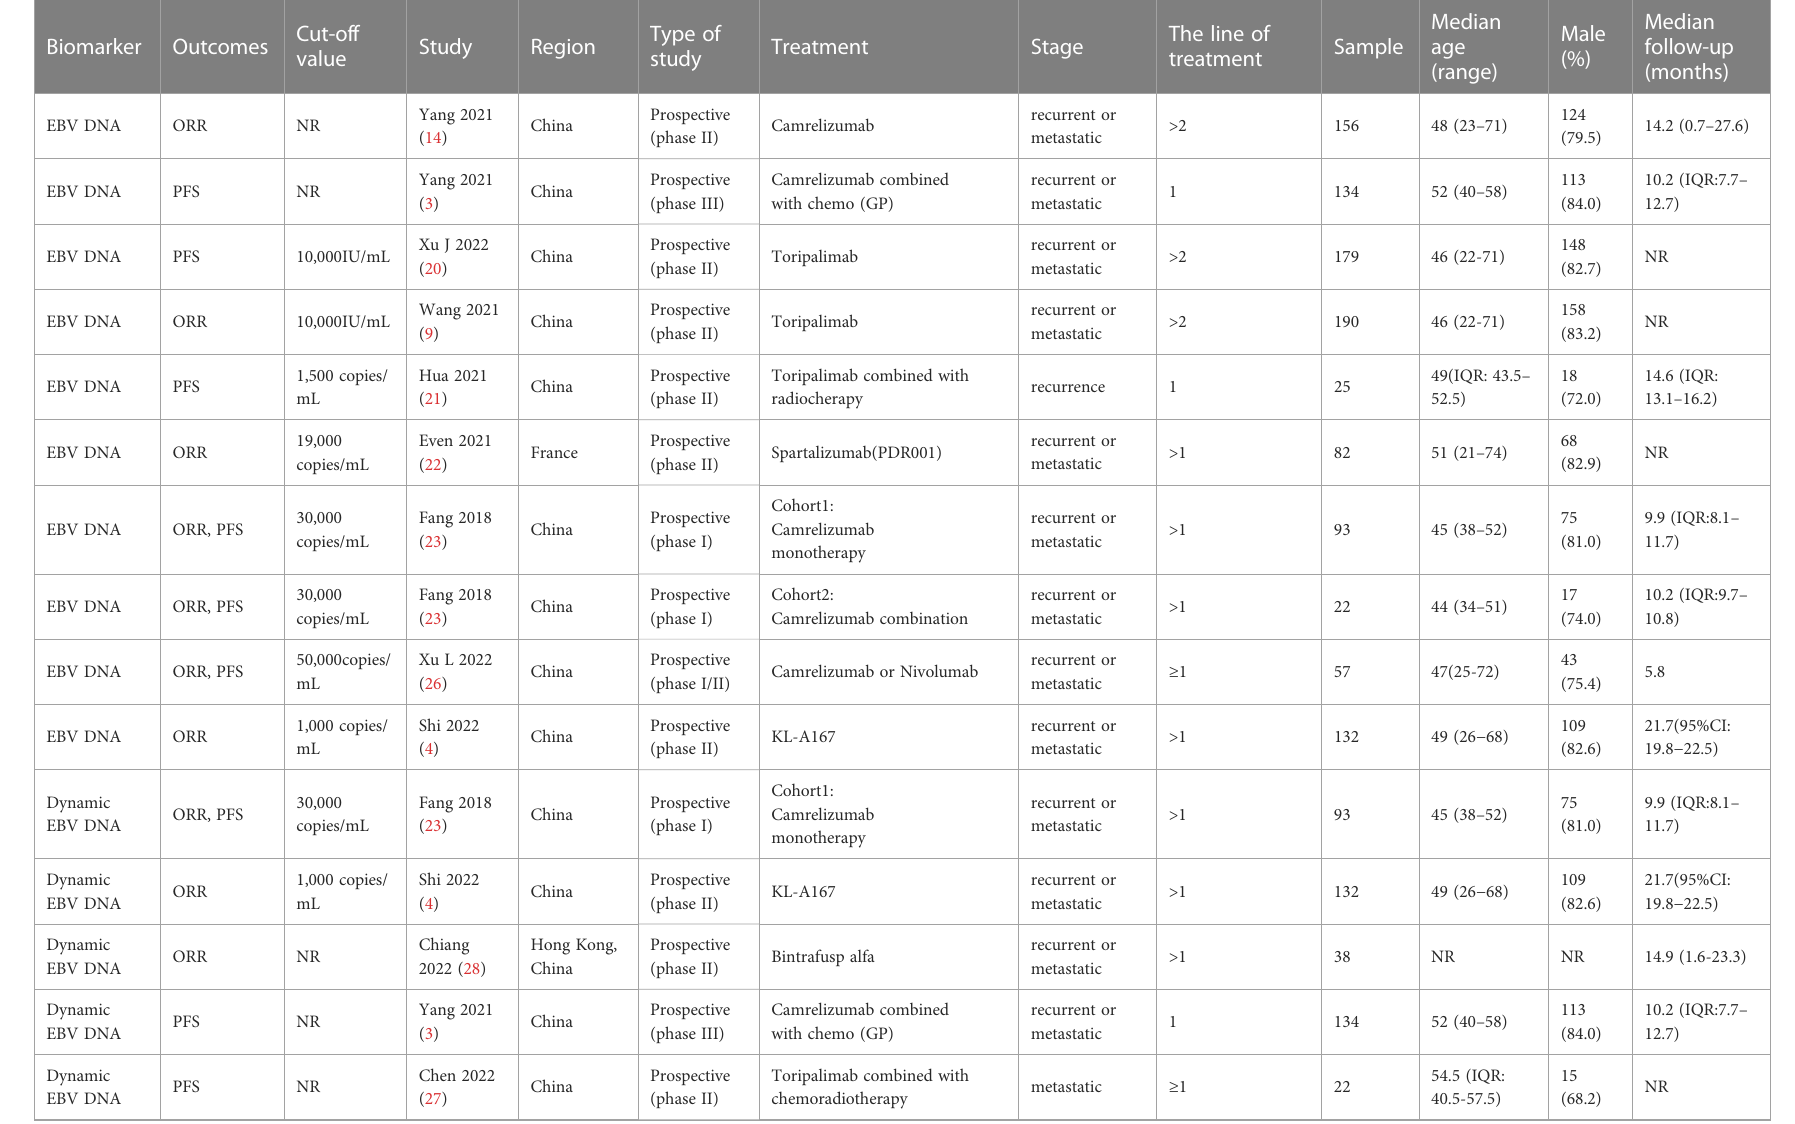
TABLE 1 Baseline characteristics of the studies included in the systematic review and